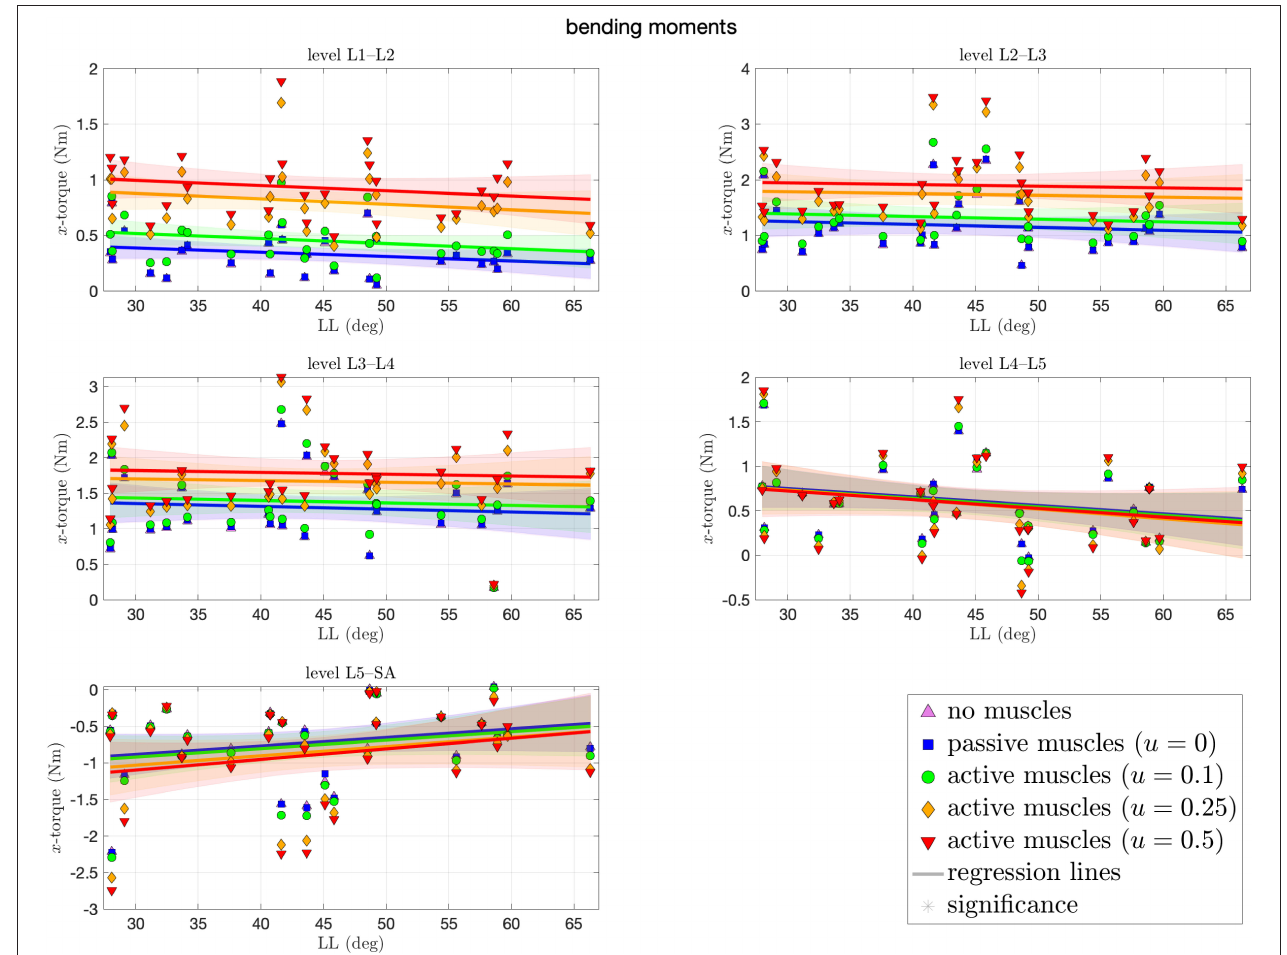
FIGURE 7 | Bending moments ( x -torques) around the transversal axis between each pair of adjacent vertebrae against lumbar lordosis (LL). Colors and marker symbols of the data points and the corresponding regression lines consistently correspond to the modes: lilac up-pointing triangles for simulations without muscles involved; blue squares for passive muscles; as well as green circles, orange diamonds, and red down-pointing triangles for muscle stimulation of u respectively. Confidence bands of the regression are shown as pale areas of the corresponding